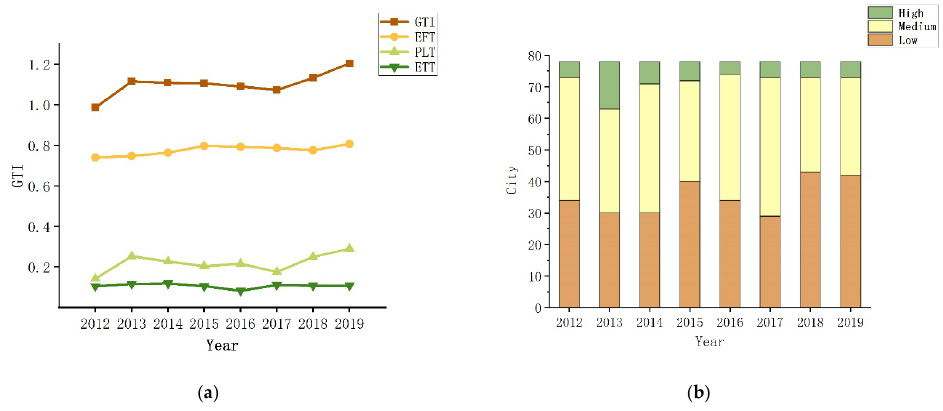
Figure 4. ( a ) Average GTI, FFT, PLT, ETT 2012–2019; ( b ) Classification of GTI 2012–2019.